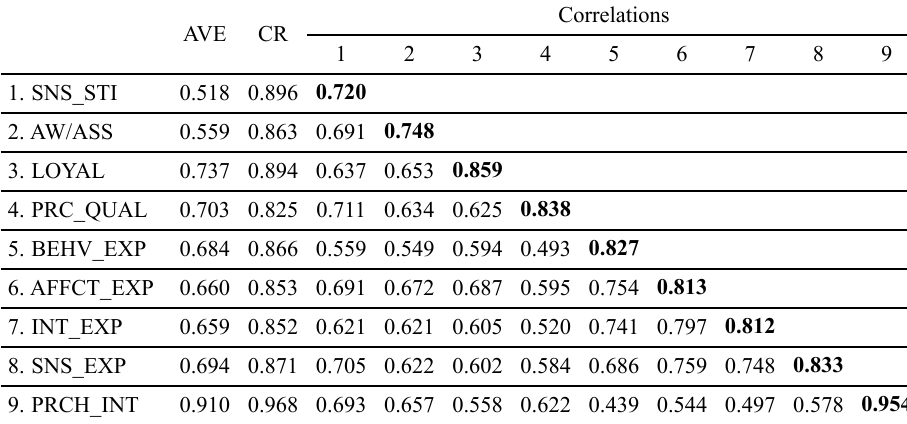
Table 2. Average variance extracted, composite reliability and correlations among latent variables